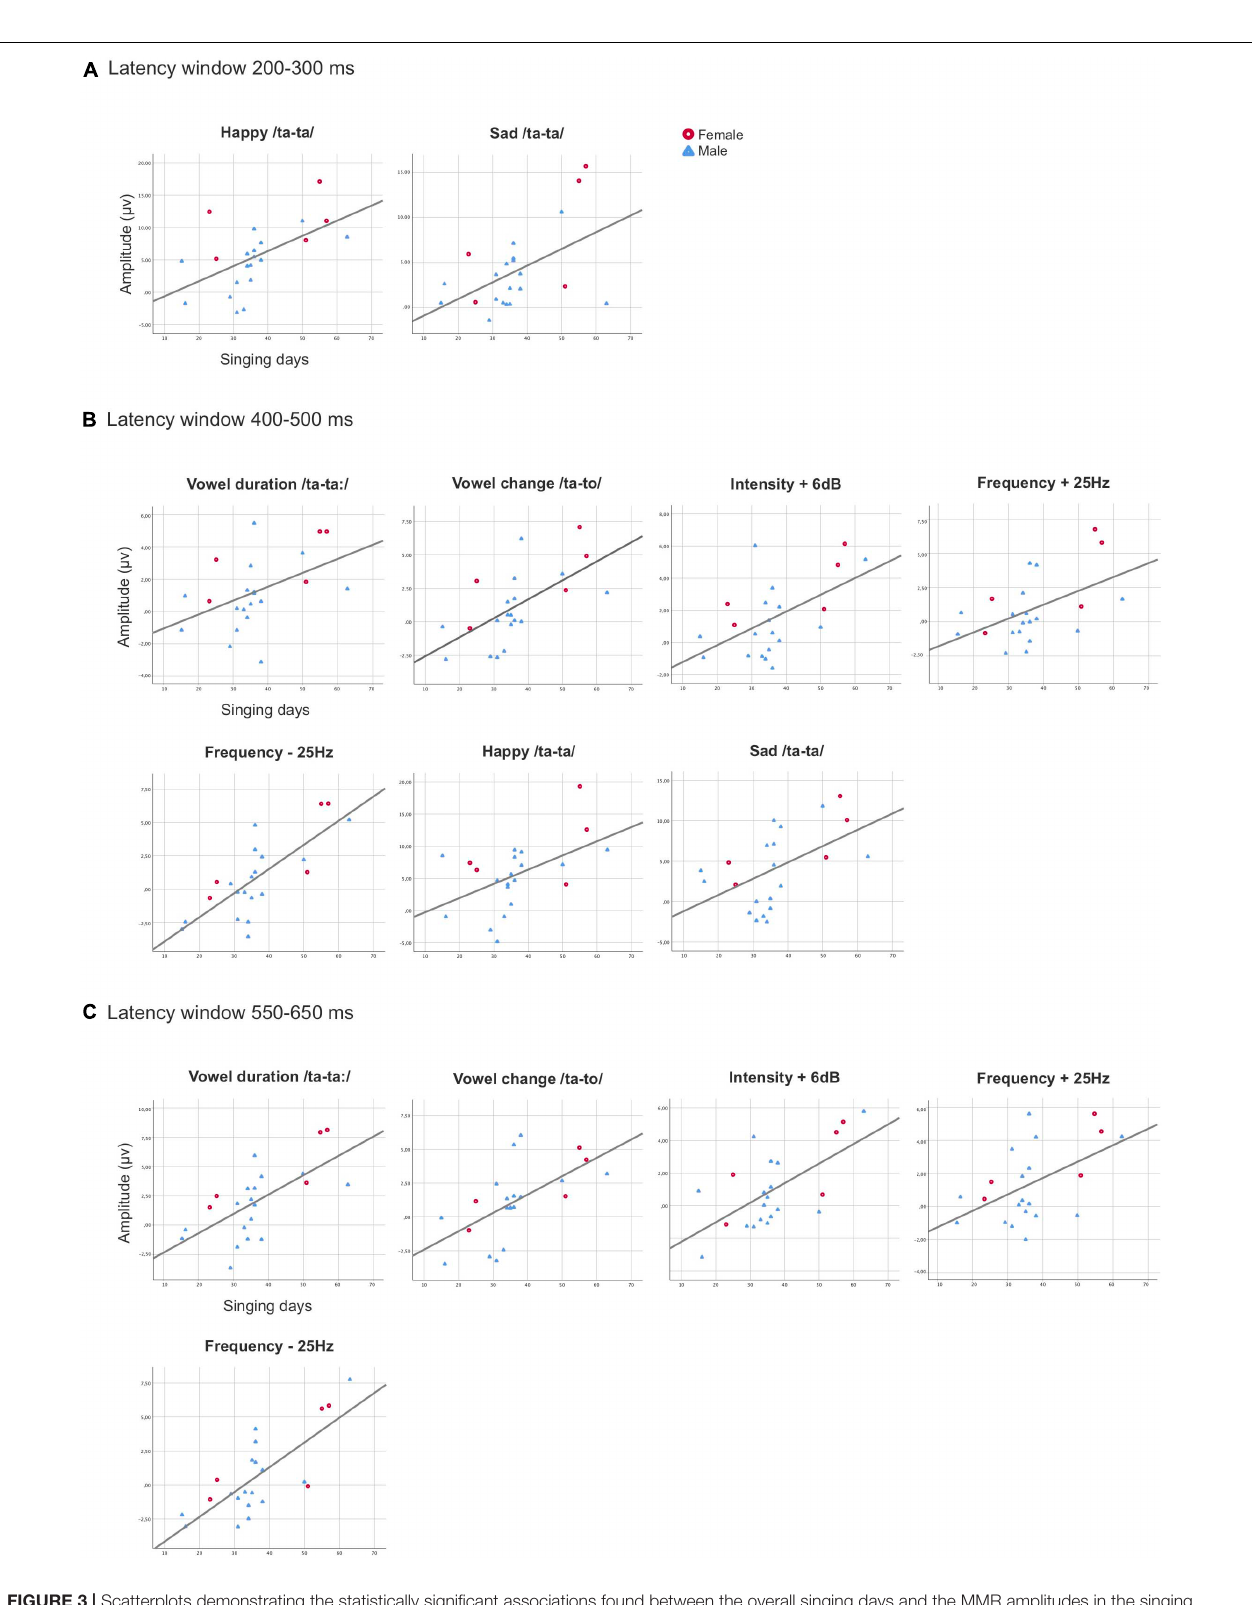
FIGURE 3 | Scatterplots demonstrating the statistically significant associations found between the overall singing days and the MMR amplitudes in the singing intervention group for the averaged values of the electrodes F3, F4, C3, and C4 combined in the latency windows 200–300 ms (A) , 400–500 ms (B) , and 550–650 ms (C) . The X-axis represents the duration of overall singing days (range from 15 to 63 days) and the y-axis represents the amplitude ( µ V) of the responses.